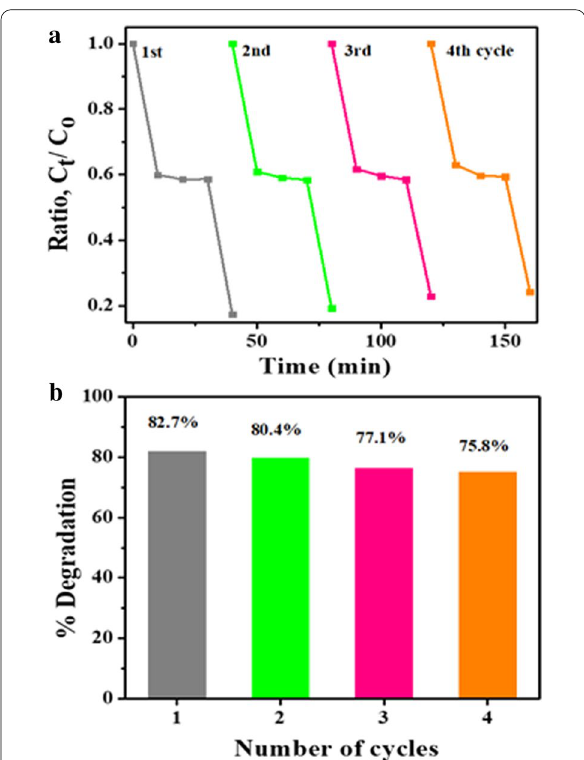
Fig. 9 a Photocatalysis reusability performance of Mg‑doped ZnO and b %degradation bar graph